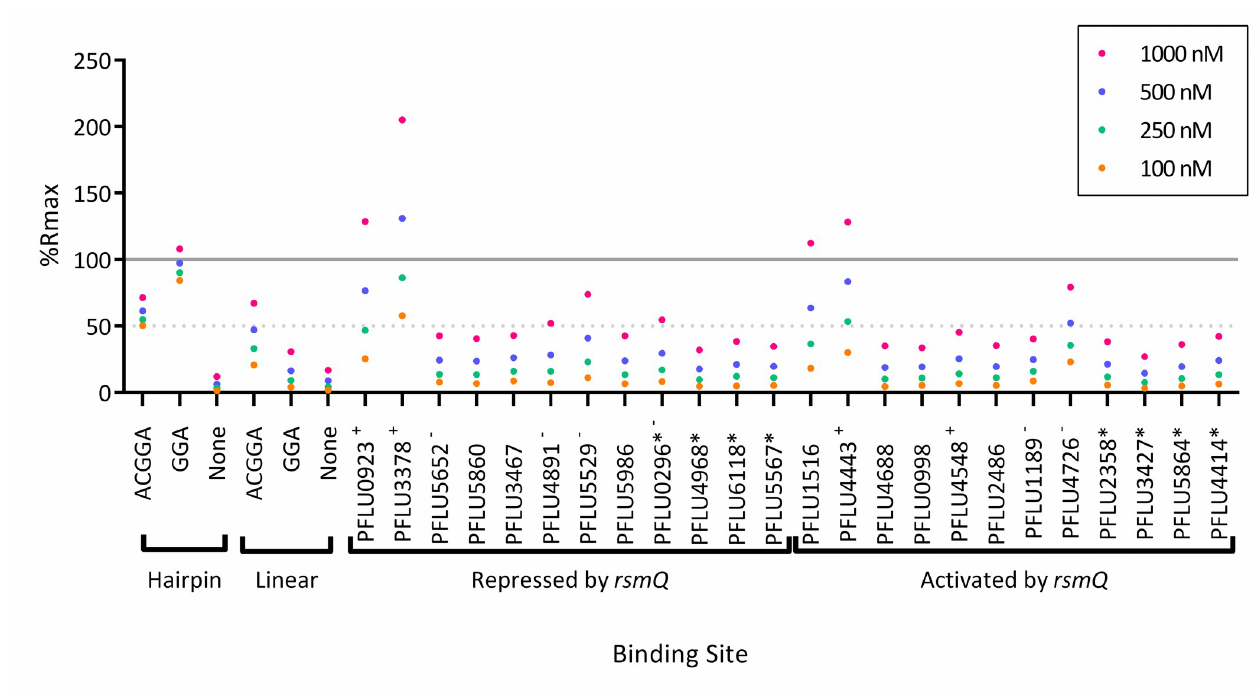
Fig 4. RsmQ binds to the upstream regions of predicted mRNA targets. Purified RsmQ was tested against ssDNA oligos with synthetic oligos run as a control. Oligos are labelled as in S4 Table, with the genetic identifiers used to indicate the binding sites associated with those ORFs. Genes annotated with a � indicate ORFs that contain a simplified GGA binding site but are not predicted to have a full Rsm (AnGGA) binding site within 500 bp upstream or the first 100 bp of the ORF. Oligos predicted to have the full AnGGA (+) or a partial AnGGA (-) at the open top of a stem loop are indicated. Percentage R max values are shown for 4 concentrations. A solid line indicates 100% R max and a dotted line for 50% R max ; 100% R max suggests 1:1 ligand protein binding as the experimentally acquired response is equal to the predicted response, with a 50% R max suggesting a weaker interaction or a 2:1/1:2 response. Each data point represents the mean of 2 replicates. Data are available in S3 Data. ssDNA, single-stranded DNA.